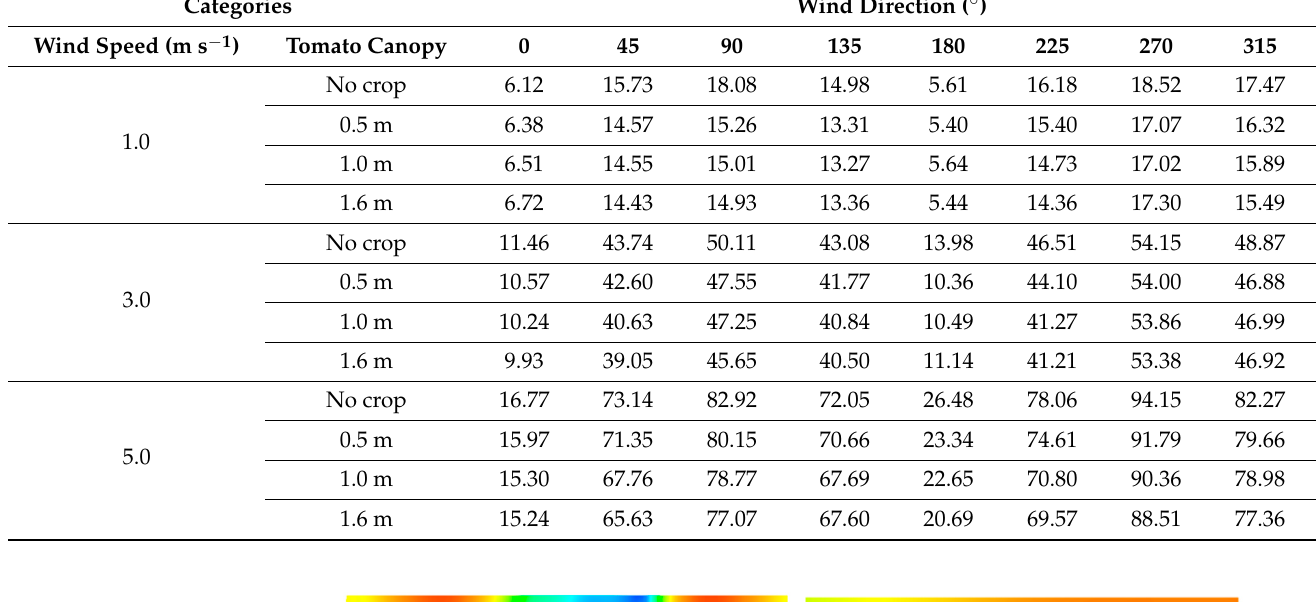
Table 7. CFD-computed ACH of the greenhouse according to WD, WS, and crop height conditions.